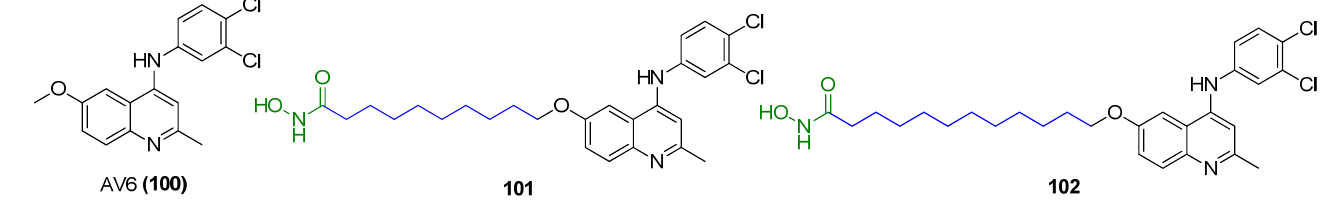
Figure 22. Chemical structures of quinoline derivatives 100~102 as